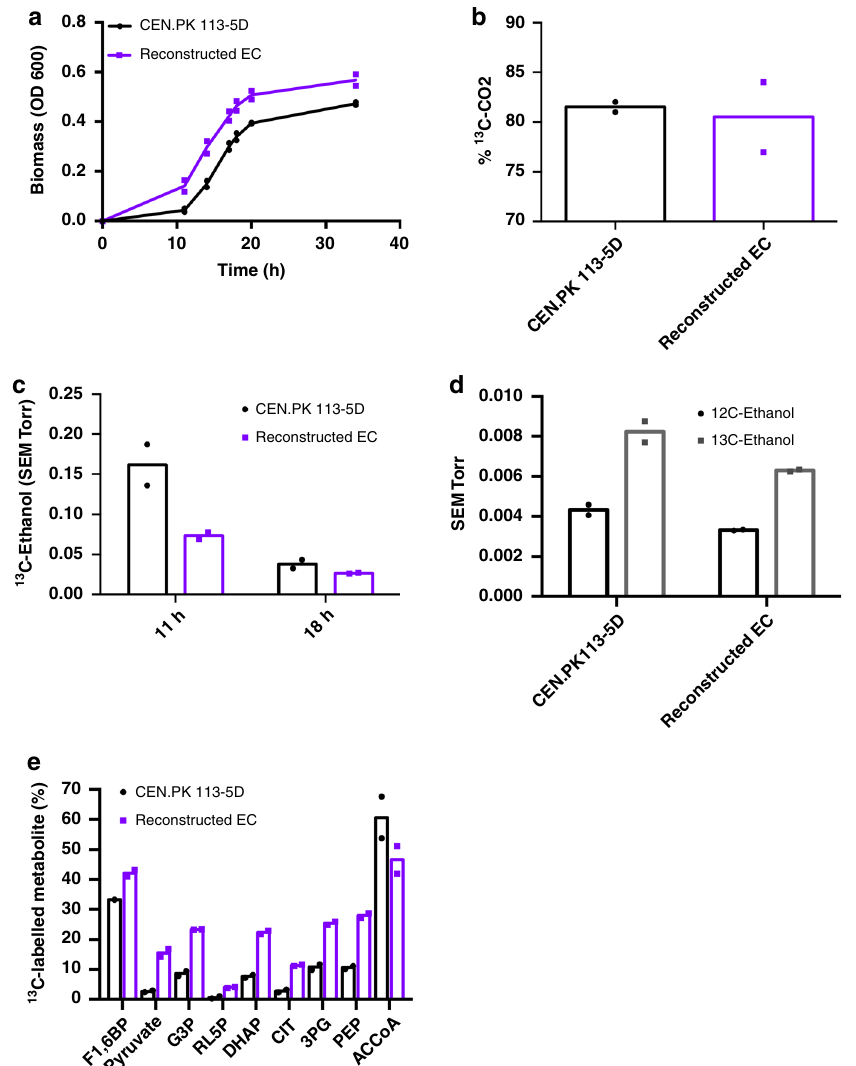
Fig. 3 13 C-methanol fermentations to characterise the reconstructed evolved strain. a Growth pro fi le of CEN.PK 113-5D and the reconstructed evolved strain grown in liquid YNB medium with 2% 13 C-methanol supplemented with 0.1% yeast extract cultures in bioreactors. Data are from two independent biological replicates with lines representing the mean. Source data are provided as a Source Data fi le. b Percentage of 13 C-CO 2 /CO 2 production in yeast extract 13 C-methanol (2%) medium from two biological replicates with bars representing the mean. c 13 C-ethanol was produced by CEN.PK 113-5D and by the reconstructed evolved strain. The signal intensity was normalised to the inert gas nitrogen, and then to biomass for each strain. Data show 13 C-ethanol intensity at 47amu for two independent biological replicates, with bars representing the mean. d Comparison of 12 C-ethanol and 13 C-ethanol intensities during growth in 13 C-methanol. The signal intensity was normalised to the inert gas nitrogen, and then to biomass for each strain. Data show the 12 C-ethanol and 13 C-ethanol intensity at 31 and 33amu, respectively, for two independent biological replicates, with bars representing means. SEM secondary electron multiplier, amu atomic mass unit. e Percentage of fully 13 C-labelled intracellular metabolite pool relative to total metabolite pool of CEN.PK 113-5D and reconstructed evolved strains. F1,6BP fructose-1,6-bisphosphate, G3P glyceraldehyde-3-phosphate, RL5P ribulose-5-phosphate, DHAP dihydroxyacetone phosphate, CIT citrate, 3PG 3-phosphoglyceric acid, PEP phosphoenolpyruvate, ACCoA acetyl-coenzyme A. Data are from two independent biological replicates, with bars representing means, except for CEN.PK 113-5D F1,6BP, for which no 12C metabolite was detected in one replicate. Purple squares represent the Reconstructed EC strain, and black circles represent the CEN.PK 113-5D strain. Source data are provided as a Source Data fi transcript abundance was observed for nine genes involved in the for fructose-1,6-bisphosphatase, a key enzyme involved in gluconeogenesis 29,30 , had lower transcript abundance. Hxk1p, and FUM3 ; Fig. 4), suggesting the TCA cycle is downregulated Glk1p, Tdh1p and Eno2p also had increased protein abundance, during growth on methanol and yeast extract. Sfa1p, which is as well as Pfk1p, suggesting glycolysis rather than gluconeogenesis involved in native formaldehyde detoxi fi cation and alcohol is predominantly occurring during growth on methanol in the oxidation also had increased protein abundance in the recon- reconstructed EC strain. The increased transcript abundance of structed EC strain. Finally, the pentose phosphate pathway the 6-phosphofructo-2-kinase glycolysis regulator PFK27 31 in the showed interesting results, with RKI1 having lower transcript reconstructed EC strain also supports this concept. Concordant abundance and Tkl2p lower protein abundance, whereas Tal1p with the metabolite pro fi le of the reconstructed EC strain, lower and Fba1p had higher protein abundance.